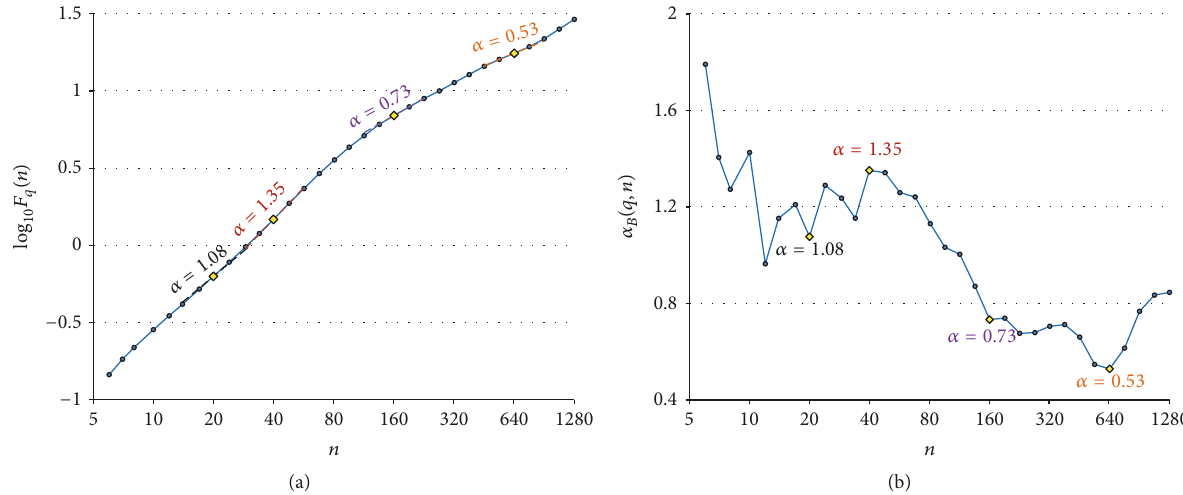
Figure 2: Example of local slopes estimation . (a) shows the same 𝐹 𝑞 (𝑛) function plotted for maximally overlapped blocks and 𝑞 = −2 in Figure 1; the straight lines spanning over 5 points centered around the diamond symbols at 𝑛 = 20 , 𝑛 = 40 , 𝑛 = 161 , and 𝑛 = 646 represent the local slopes 𝛼(𝑛) evaluated by the 5-point derivative of (5). (b) shows the corresponding spectrum of local slopes.